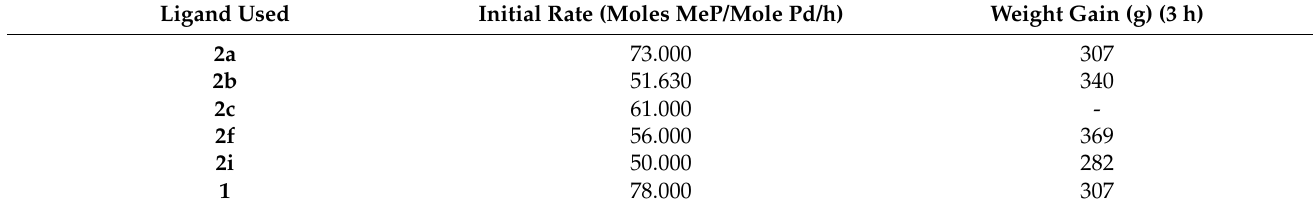
Table 5. Comparison of the lifetimes of catalysts derived from bulky ligands 2b , 2c , 2f , and 2i , with prototypic palladium dichloride complexes of ligands 1 and 2a , under optimised conditions.